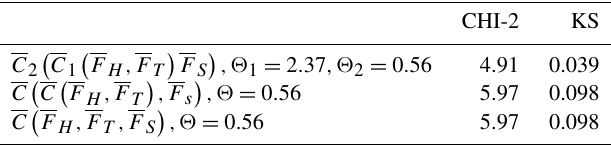
Table 8. Goodness of fit of the trivariate copulas for the port of Le